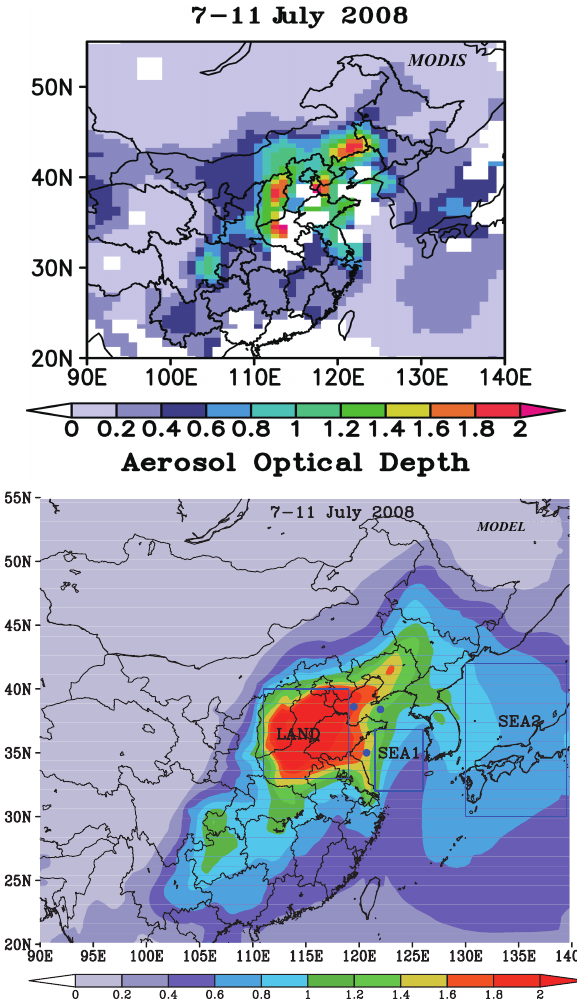
Figure 1. The averaged MODIS (top) and modelled AOD (bottom) during the period of 7–11 July 2008: LAND represents the polluted area in 3JNS; points A, B and C represent offshore China; domains SEA1 and SEA2 refer to China’s Huang Sea and the Sea of